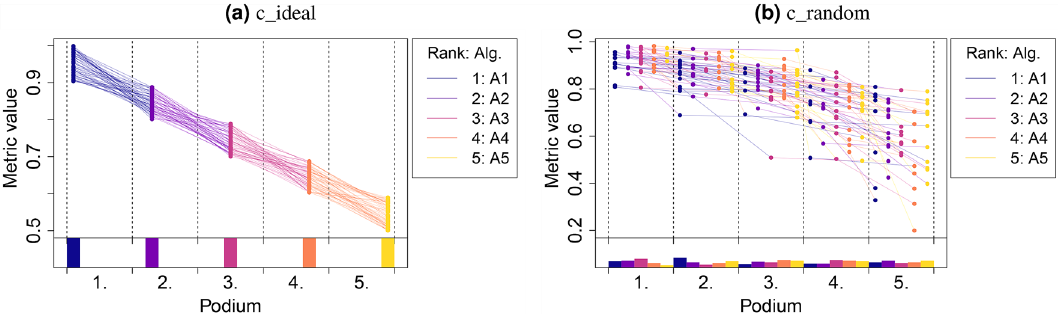
Figure 2. Podium plots 9 for visualizing assessment data. Upper part: participating algorithms are color-coded, and each colored dot in the plot represents a metric value achieved with the respective algorithm. The actual metric value is encoded by the y-axis. Each podium (here: p = 5 ) represents one possible rank, ordered from best (1) to worst (here: 5). The assignment of metric values (i.e. colored dots) to one of the podiums is based on the rank that the respective algorithm achieved on the corresponding test case. Note that the plot part above each podium place is further subdivided into p ‘columns’, where each column represents one participating algorithm. Dots corresponding to identical test cases are connected by a line, producing the spaghetti